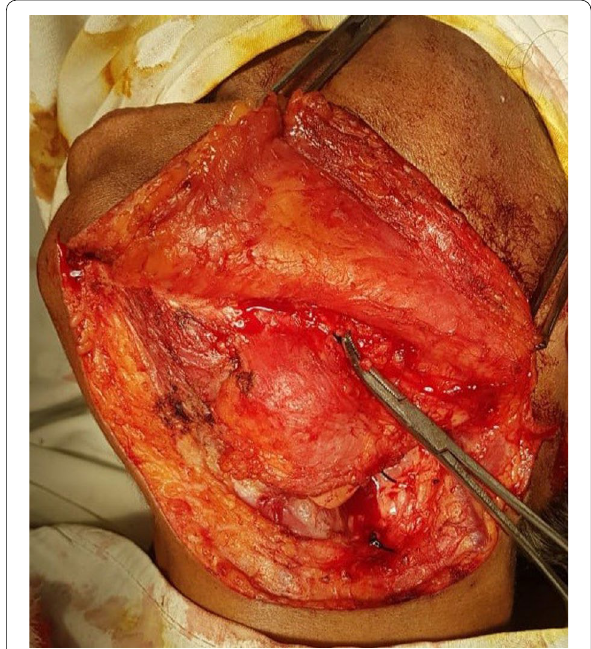
Fig. 4 Flap was raised sub-platysmal